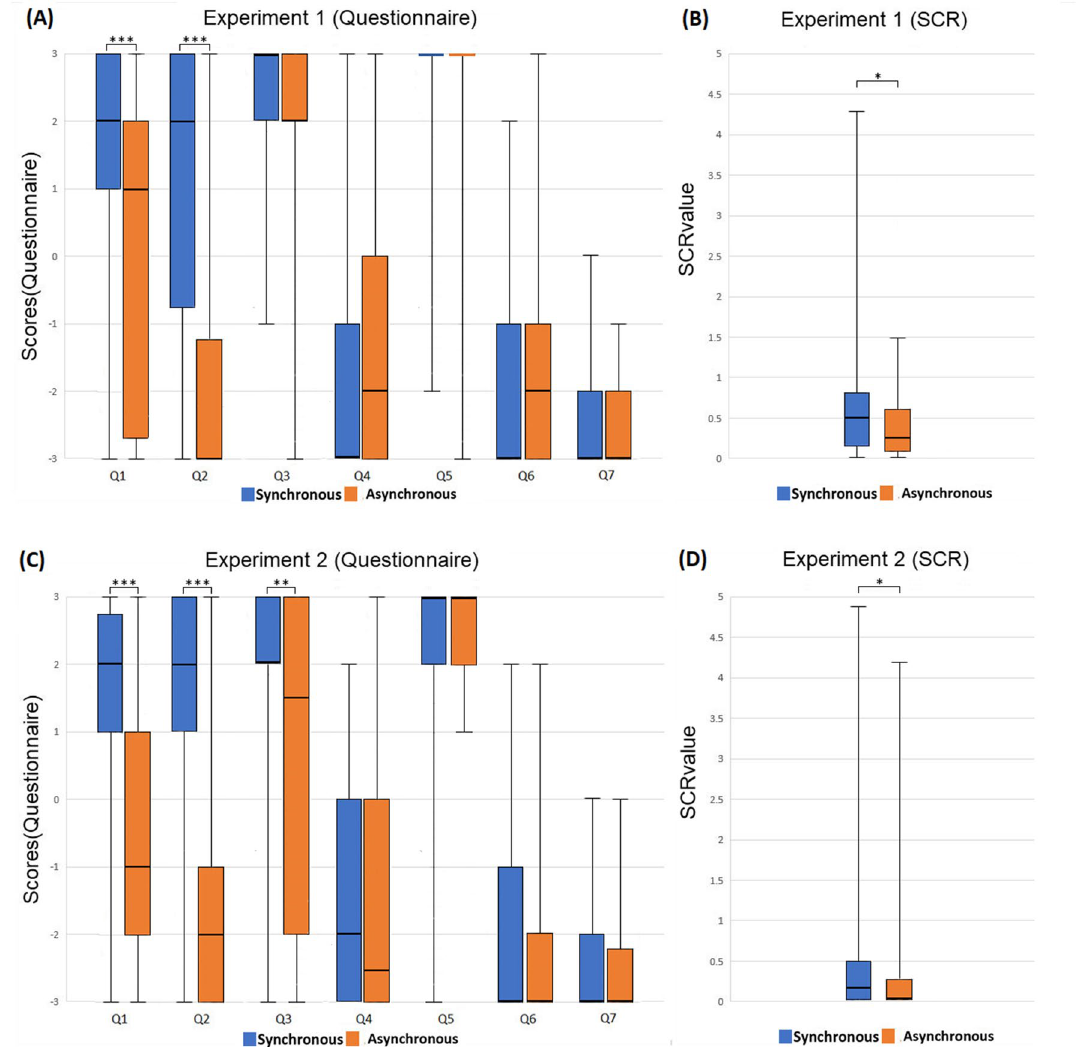
Figure 2. Results of Experiments 1 and 2. ( A ) The box chart of each question of Experiment 1. ( B ) The box chart of SCR values of Experiment 1. ( C ) The box chart of each question of Experiment 2. ( D ) The box chart of SCR values of Experiment 2. The error bars represent the maximum/minimum value. SCR value = (∆SCR in SP)/(SCR value range in RP). Significance levels: * p < 0.05; ** p < 0.01; *** p <